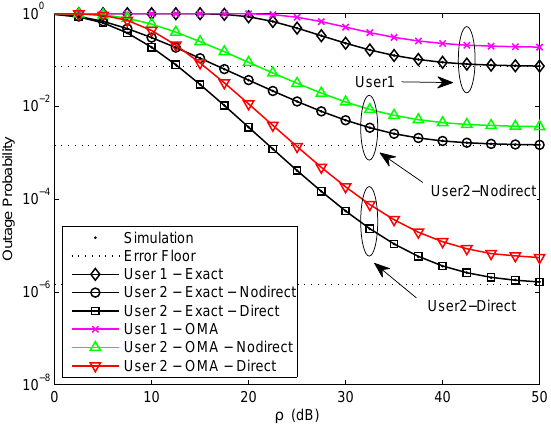
Figure 2. Outage probability versus transmit signal–noise–ratio